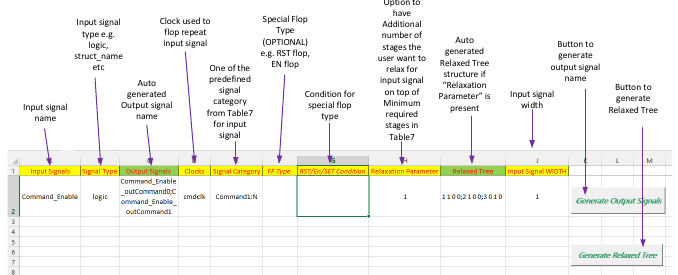
Figure 7. RTL Generator